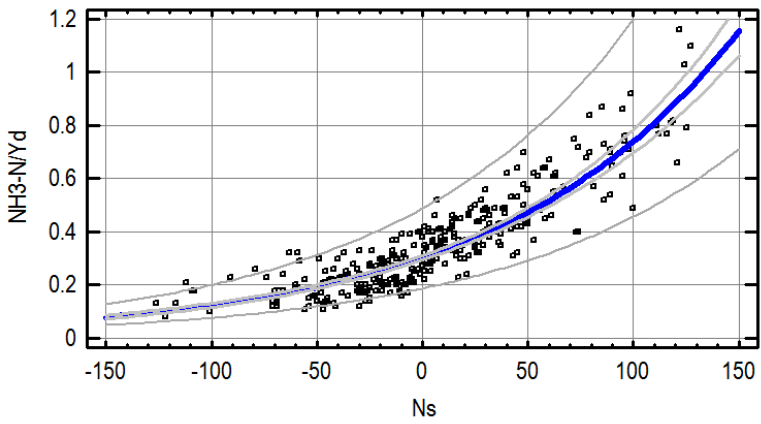
Figure 9. Observed and predicted yield-scaled NH 3 emissions (NH 3 /Yd, kg N·Mg −1 ) depending on nitrogen surplus (Ns, kg N·ha −1 ) (NH 3 /Yd = exp(−1.197 + 0.00895*Ns; R 2 = 76.6%, n = 320) .